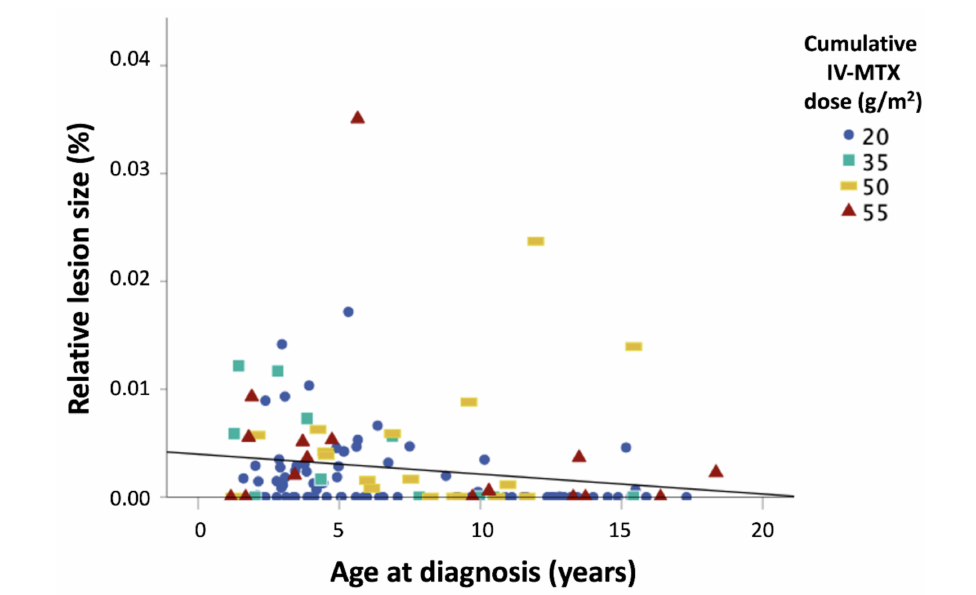
Figure 2. Scatter plot of lesion sizes and age at diagnosis. Individual ages at diagnosis are depicted ( y -axis) against lesion size values ( x -axis), colored by IV-MTX dose. Lower cumulative MTX doses of 20 g/m 2 and 35 g/m 2 are presented in dark and light blue, while higher doses of 50 and 55 g/m 2 are presented in yellow and red, respectively. While the age range of non-lesioned patients (i.e., lesion size = 0.000) covers a wide range, the ages of lesioned patients are more densely distributed in the younger age